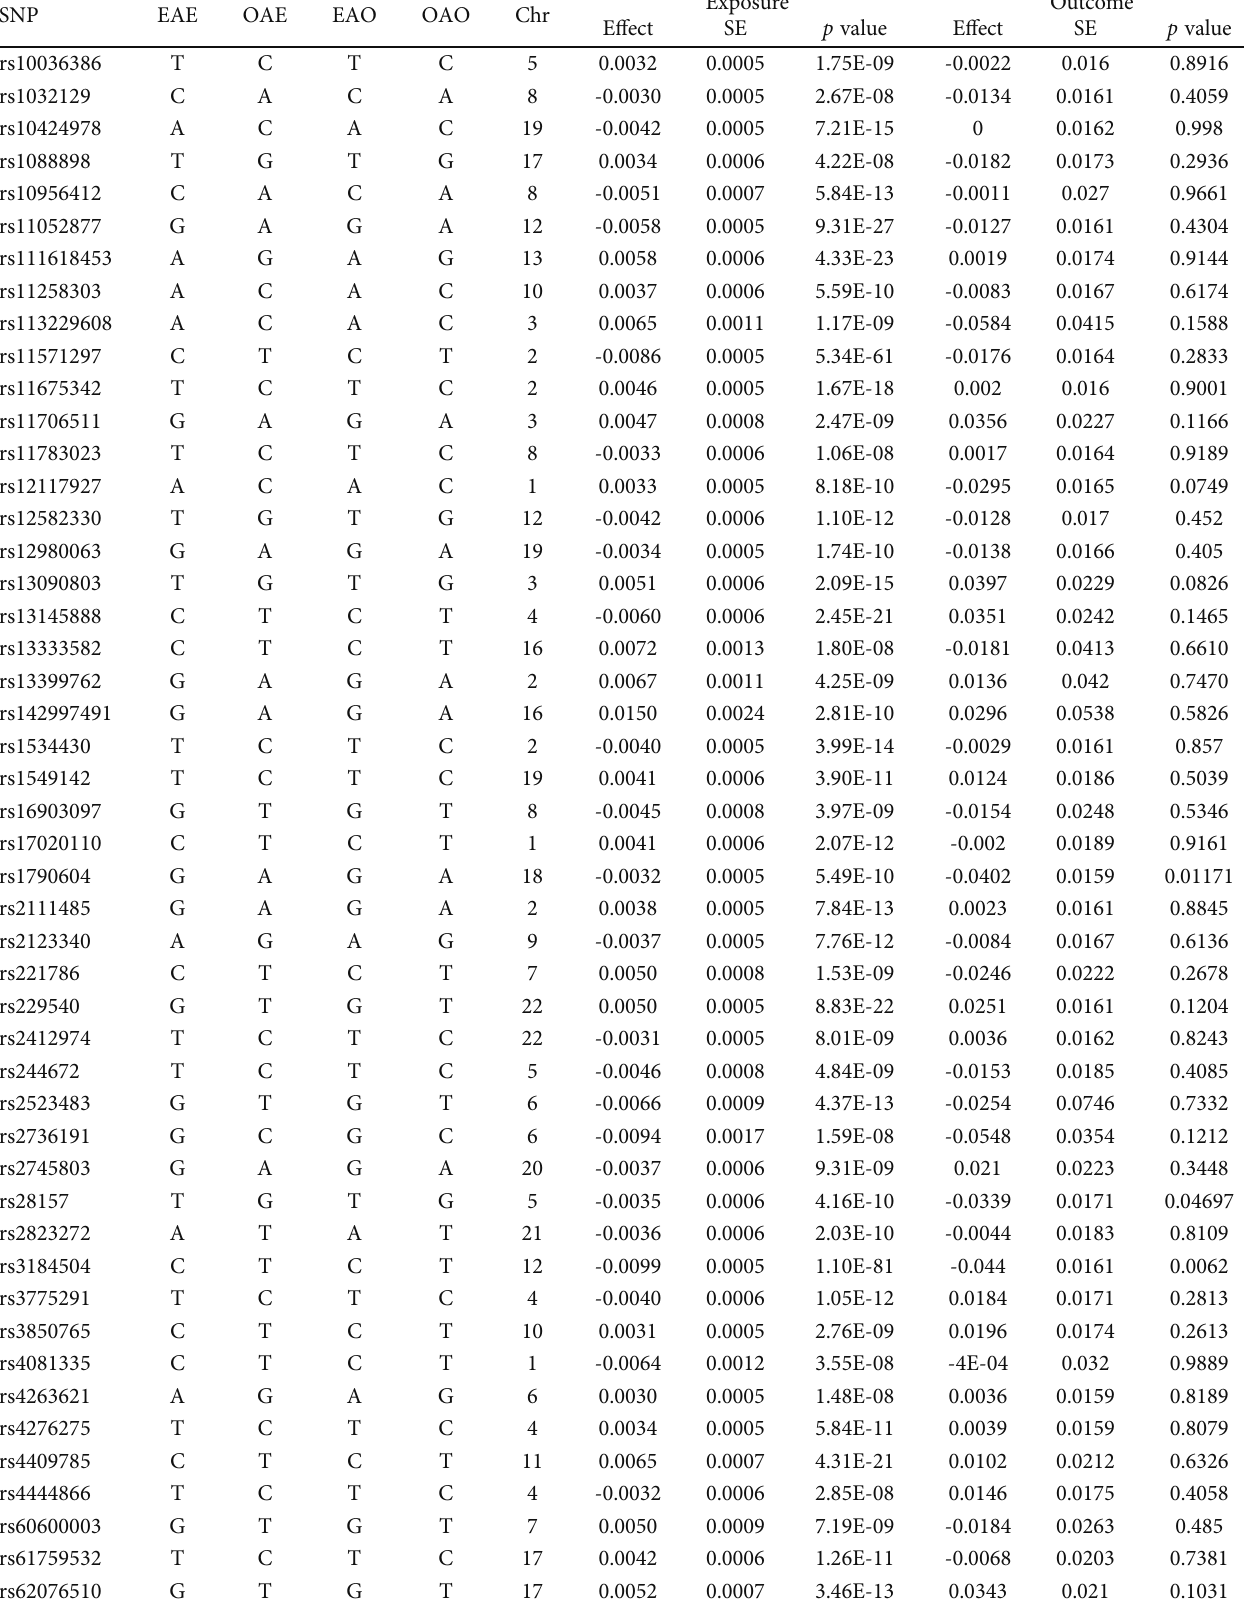
Table 5: Univariate Mendelian randomization analysis for the e ff ects of hypothyroidism on venous thromboembolism